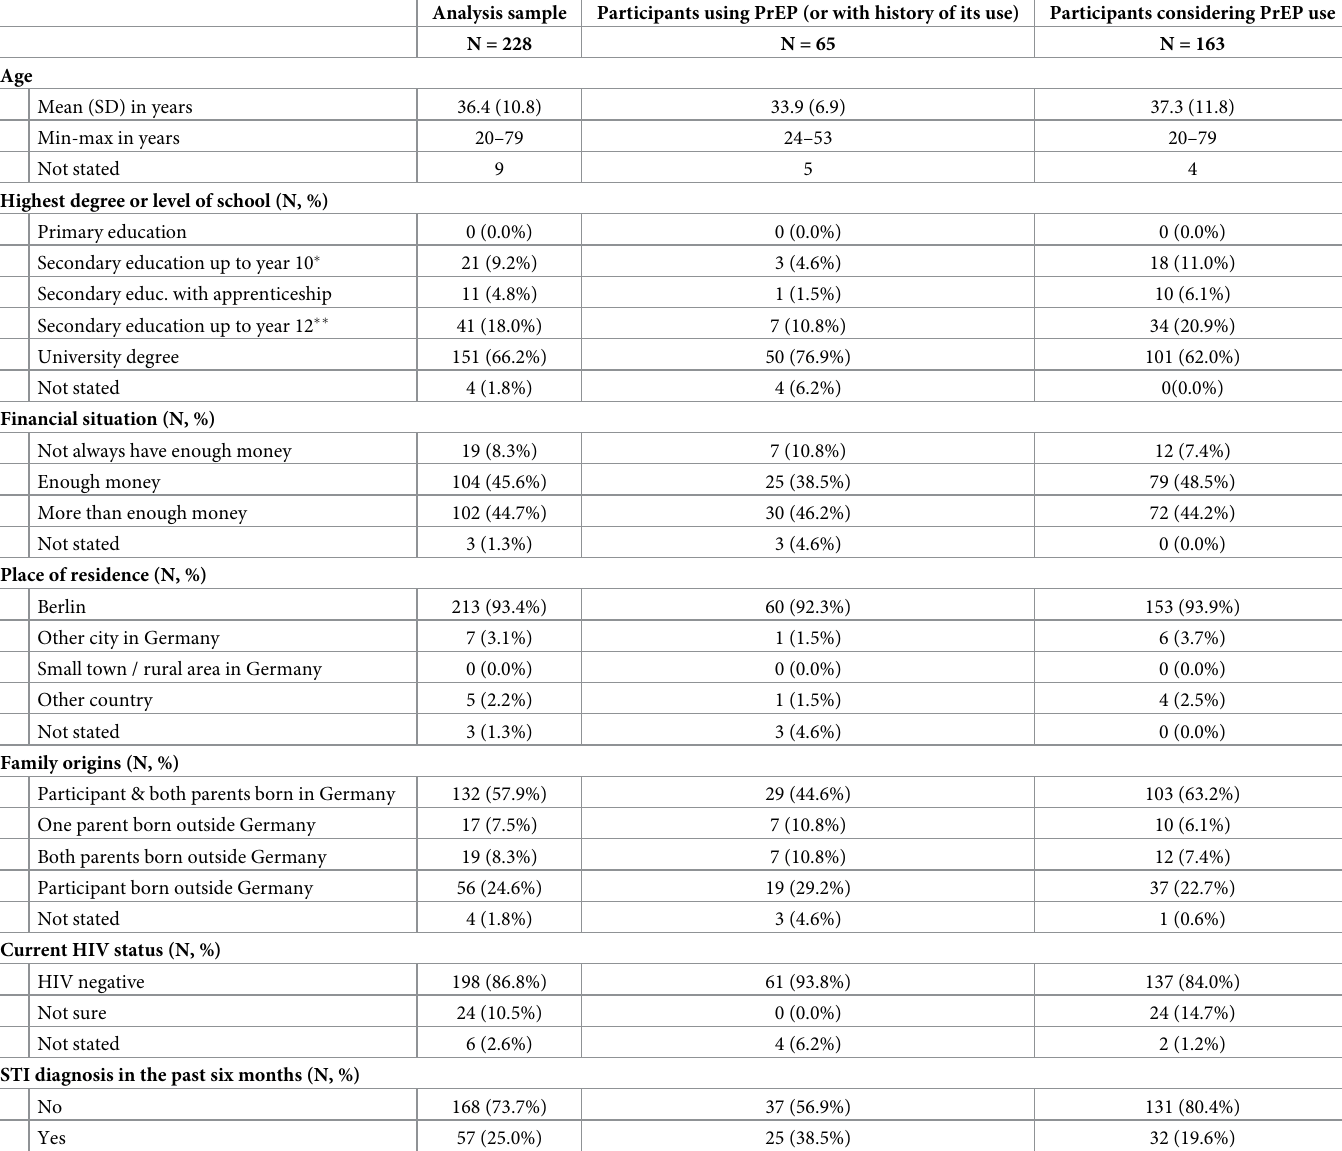
Table 2. Demographic data and sexual risk behaviour of participants who answered the question about their motivation for using or considering PrEP. Analysis